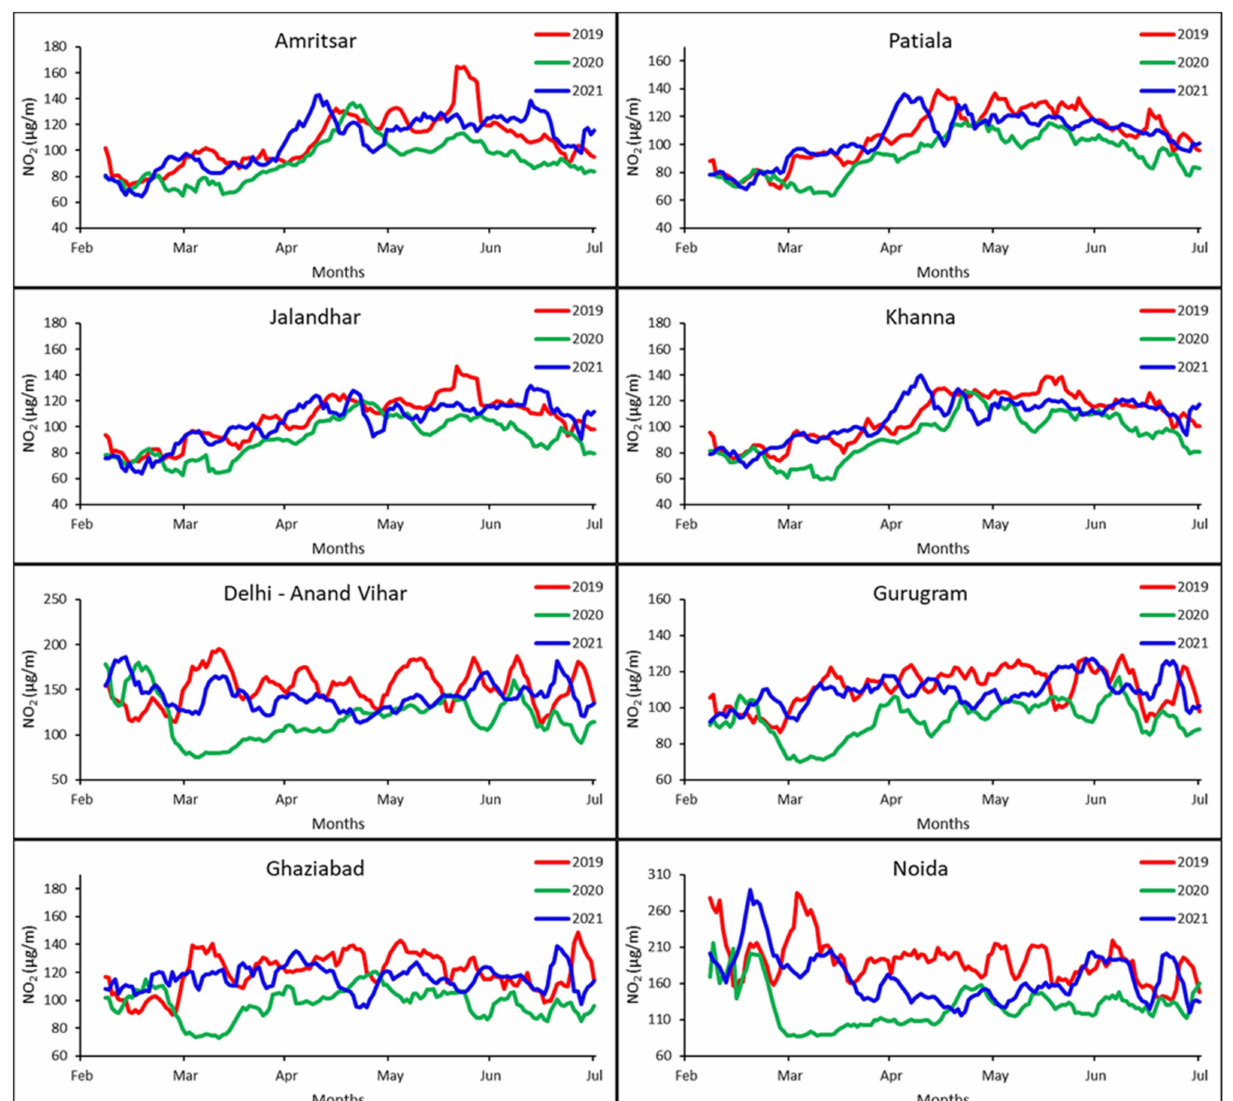
Figure 4. Sentinel-5P satellite-based NO 2 emission comparisons over Amritsar, Jalandhar,